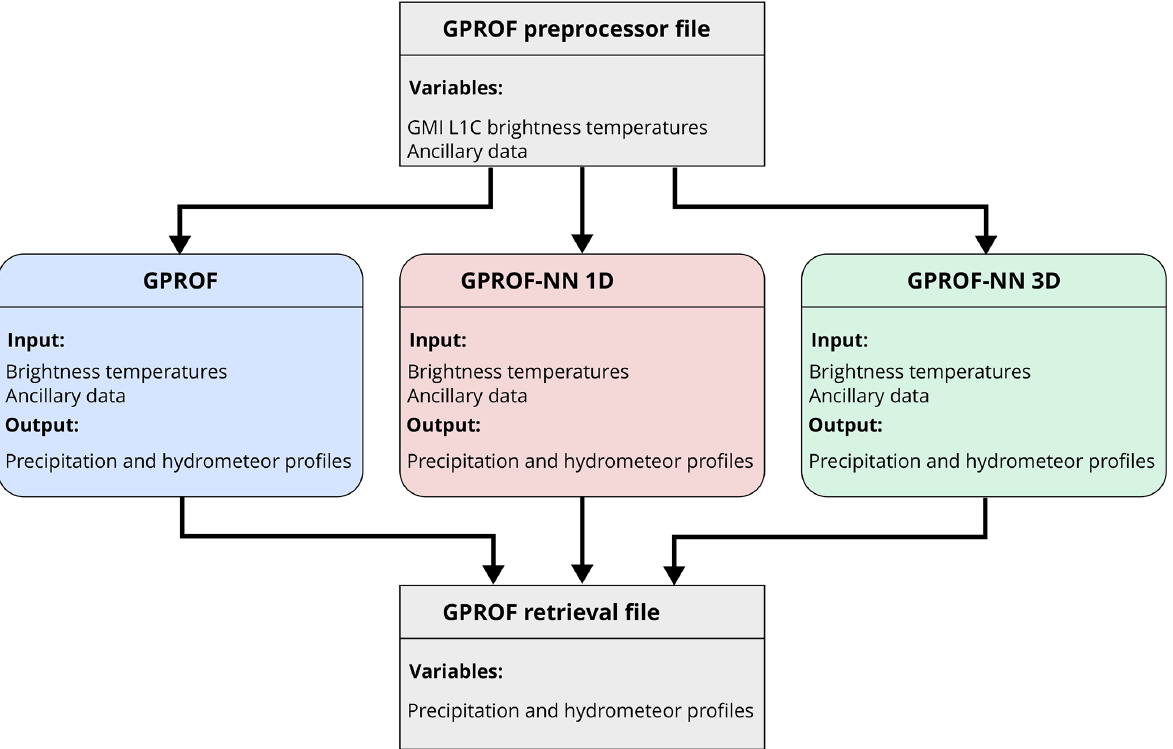
Figure B2. Data flow diagram for the application of the GPROF and GPROF-NN retrievals. The input for all retrievals is a GPROF prepro- cessor file, which is a binary file that contains the brightness temperatures and corresponding ancillary data. From this input, all retrievals produce the retrieval results, which are stored in a common binary format before being converted to HDF5